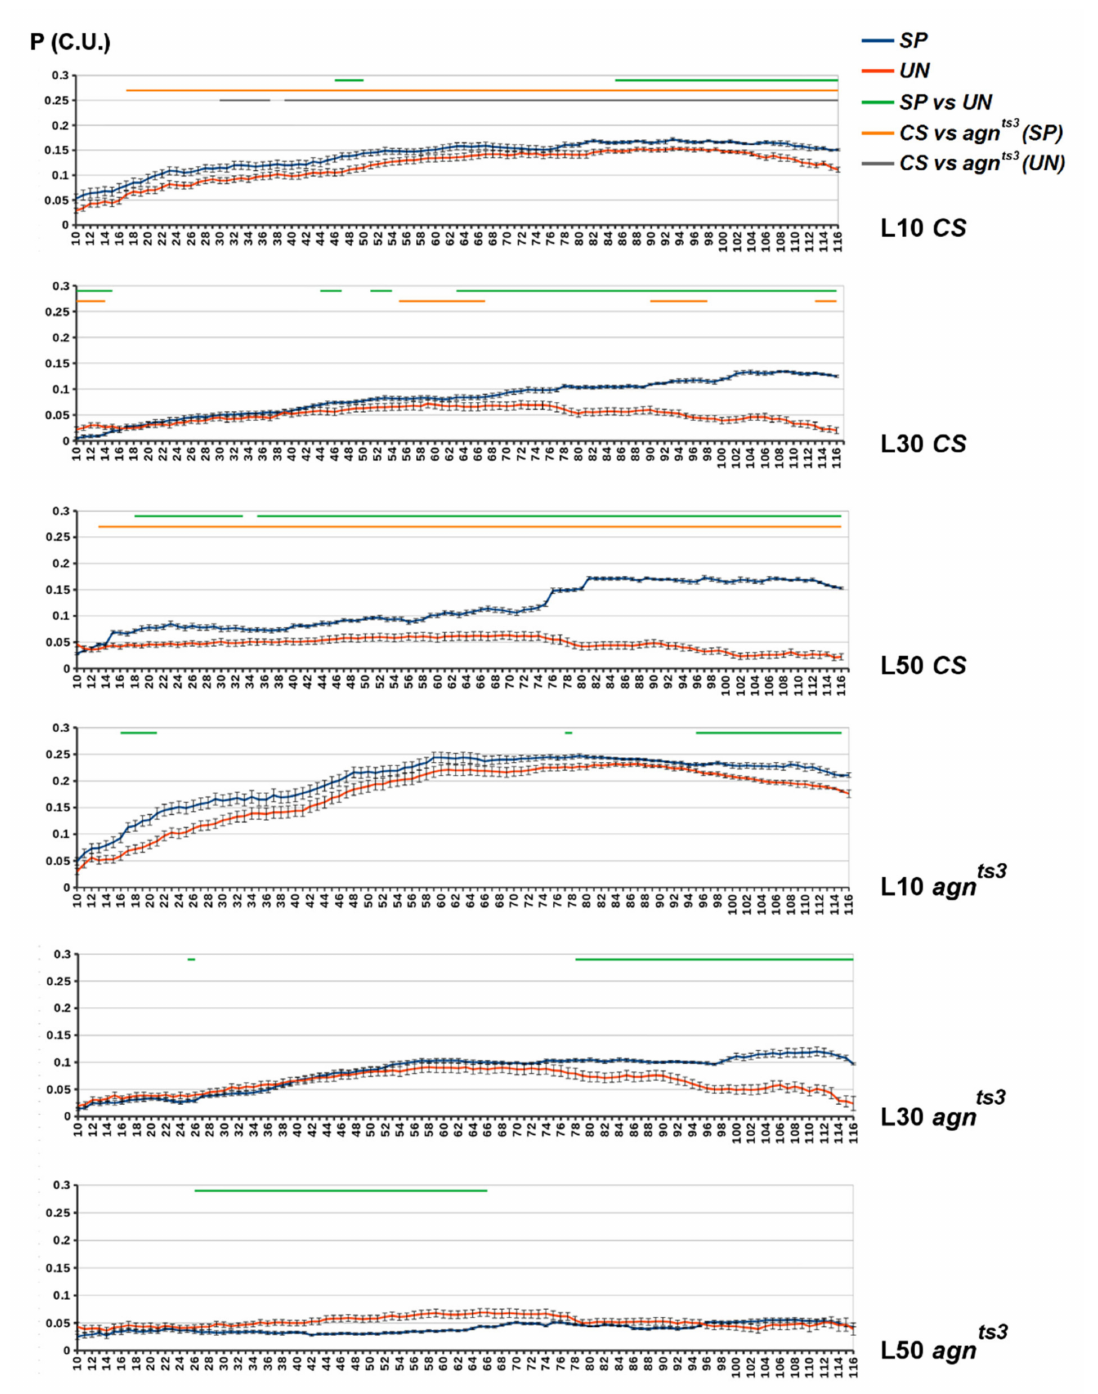
Figure 4. The average P values for the chromosomal zones of different intersection distances (D). X axis: D—zone length (in sections). Y axis: P (conventional units). Standard error of mean is shown. The areas of D with statistical differences are shown by straight lines above the diagram: green—SP vs. UN, orange—SP ( CS ) vs. SP ( agn ts3 ), grey—UN ( CS ) vs. UN ( agn ts3 ) (two-sided Mann–Whitney U-test; p < 0.05, n =